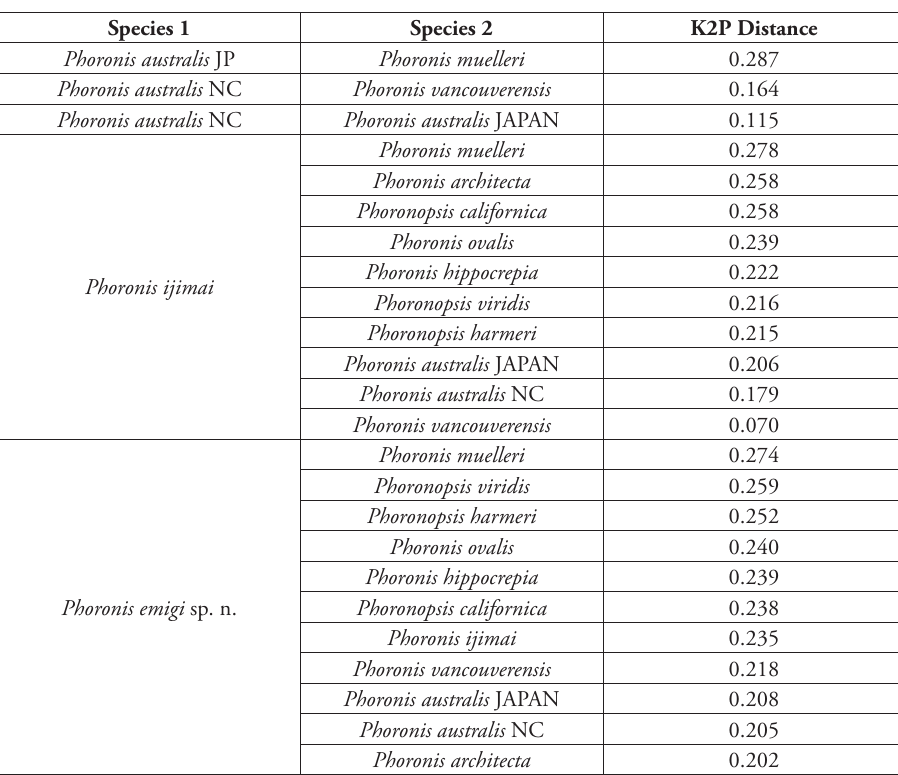
Table 2. Pairwise genetic distances (K2P distances) based on 583 positions of COI sequences between P. ijimai, P. emigi , and the other species. The largest ( P. australis JP and P. muelleri ) and the lowest ( P. australis NC and P. vancouverensis ) interspecific distances are also listed. The analysis involved 12 phoronid